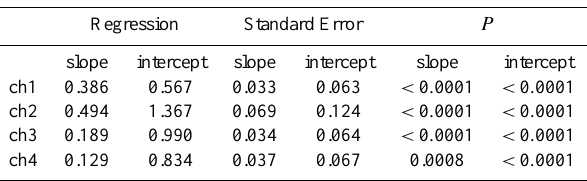
Fig. 4. Regressions between soil respiration ( R sc ) and ecosystem respiration ( R eco ) rates as measured during nights by the automated open (chamber) system, and the eddy technique, respectively. Data for chambers in vegetation gaps (Ch1 and Ch2) and trenched plots (Ch3 and Ch4) are shown. Only original (not gapfilled) storage cor- rected and u ∗ -filtered ( u ∗ > 0.1ms − 1 ) eddy data (half hourly aver- ages) and R sc data with pressure difference (between the chambers’ headspace and the ambient air) less than 0.15Pa were used in the analyis. Table 3. Statistical parameters for the regression between chamber (ch1–ch4) vs EC ( R eco )